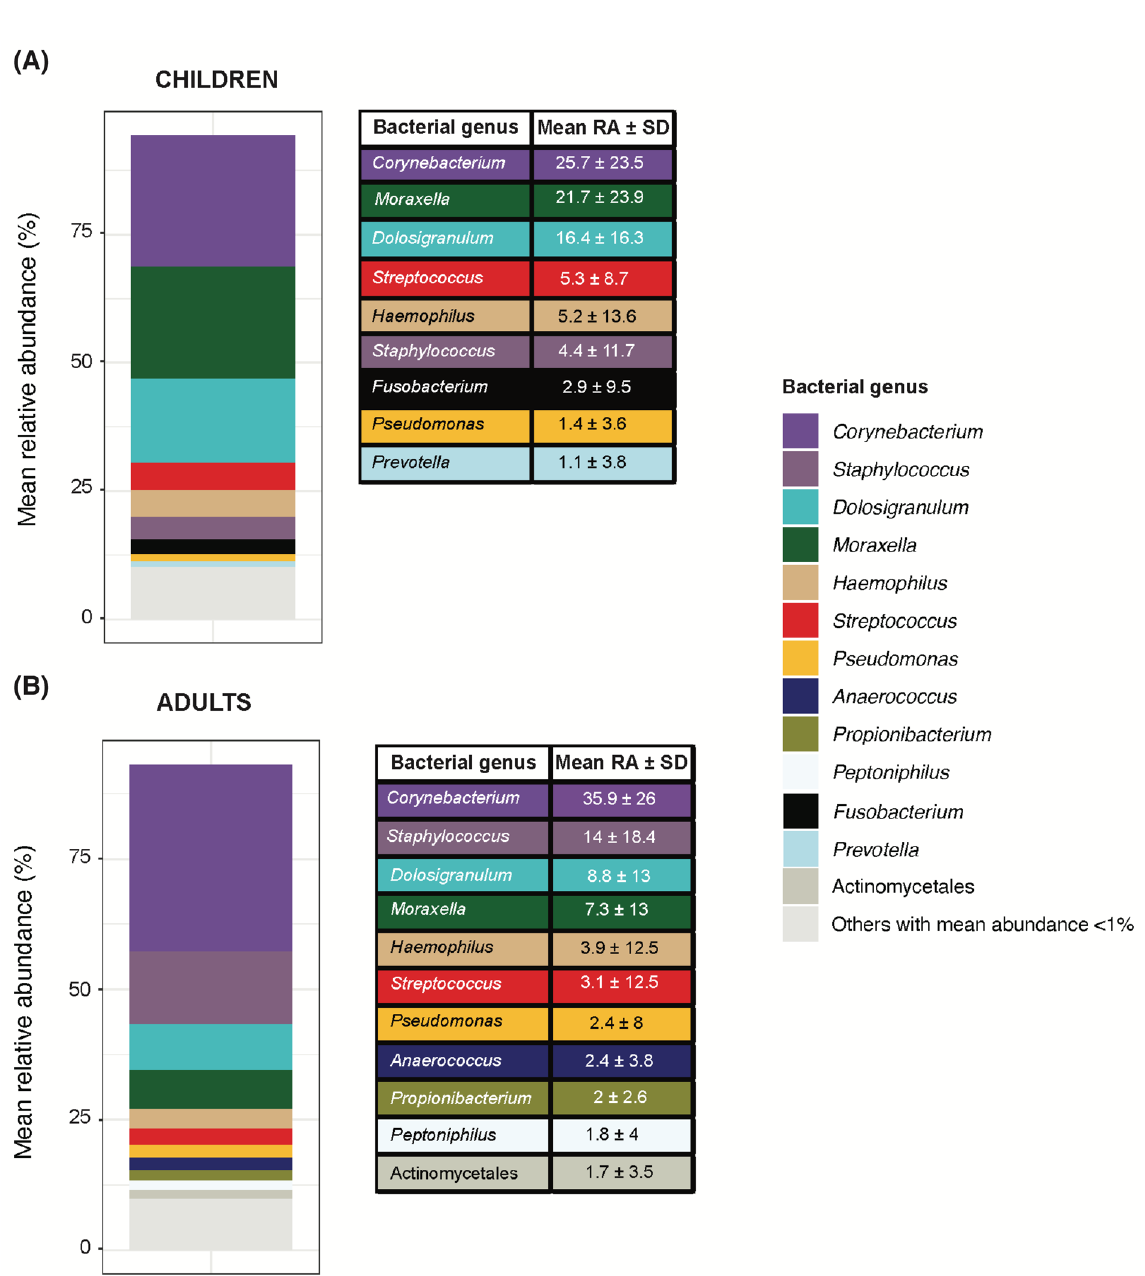
Figure 1. Bacterial genera composition in the nasopharynx of children and adults. Bacterial genera were filtered by a minimum of 0.01% relative abundance in at least 10% of samples within each study group (children in ( A ) and adults in ( B )). Only bacterial genera with a mean abundance > 1% are shown in the table ranked from most to least abundant in each group. Same genera are properly identified by color coding as shown in the legend and kept consistent in the two groups. Bacterial genera whose mean relative abundance was <1% are grouped into “others”.